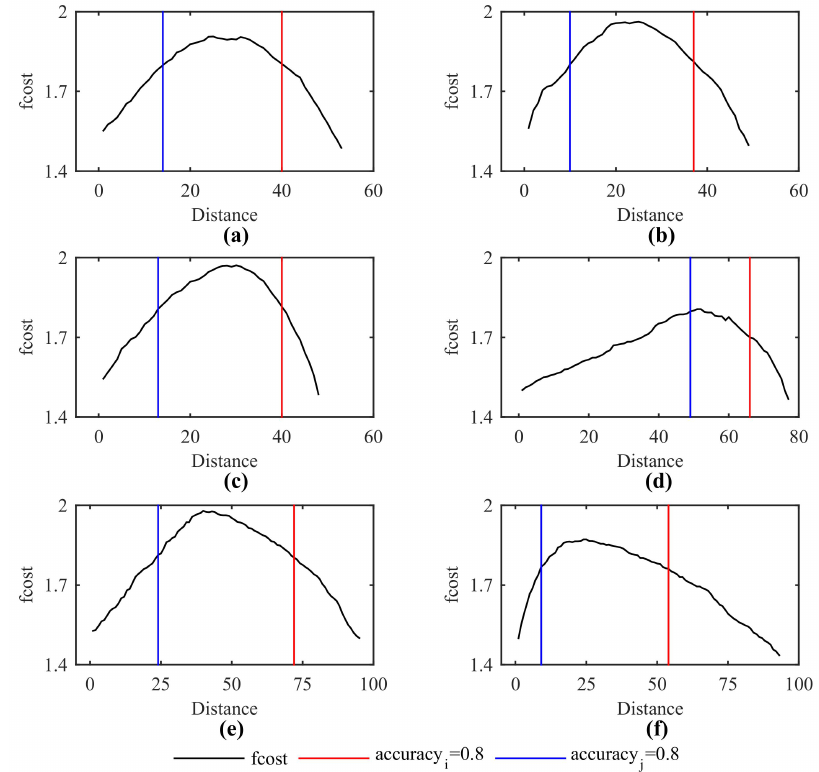
Figure 12. Fcost and thresholds of six boundaries. (a) Multibranch and dihedral. (b) Multibranch and cylinder. (c) Multibranch and sphere. (d) Dihedral and cylinder. (e) Dihedral and sphere. (f) Cylinder and sphere.